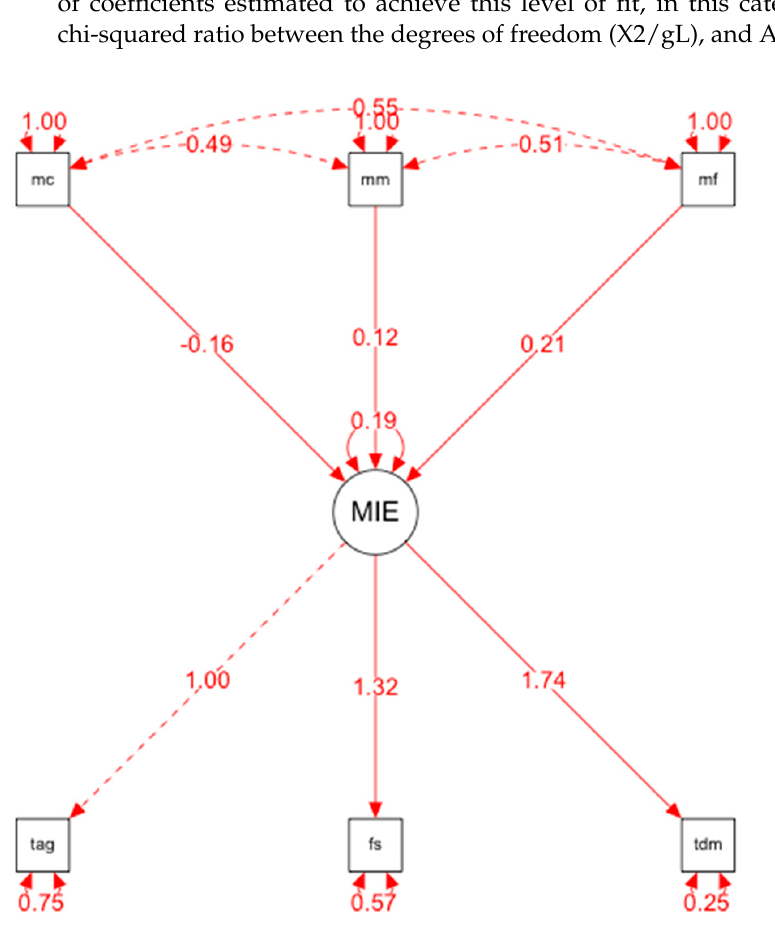
Figure 1. Structural equational modelling.